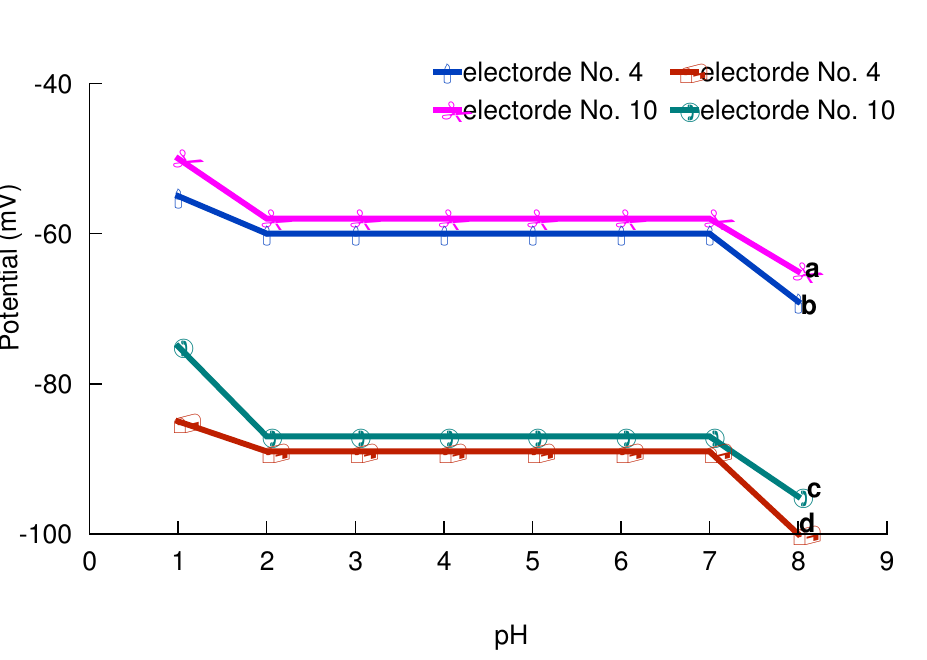
Figure 4: Effect of pH on cell potential of electrode Nos. 4 and 10 at 1.0x10 -3 M (a, b) and 1.0x10 -4 M (c, d) Ni 2+